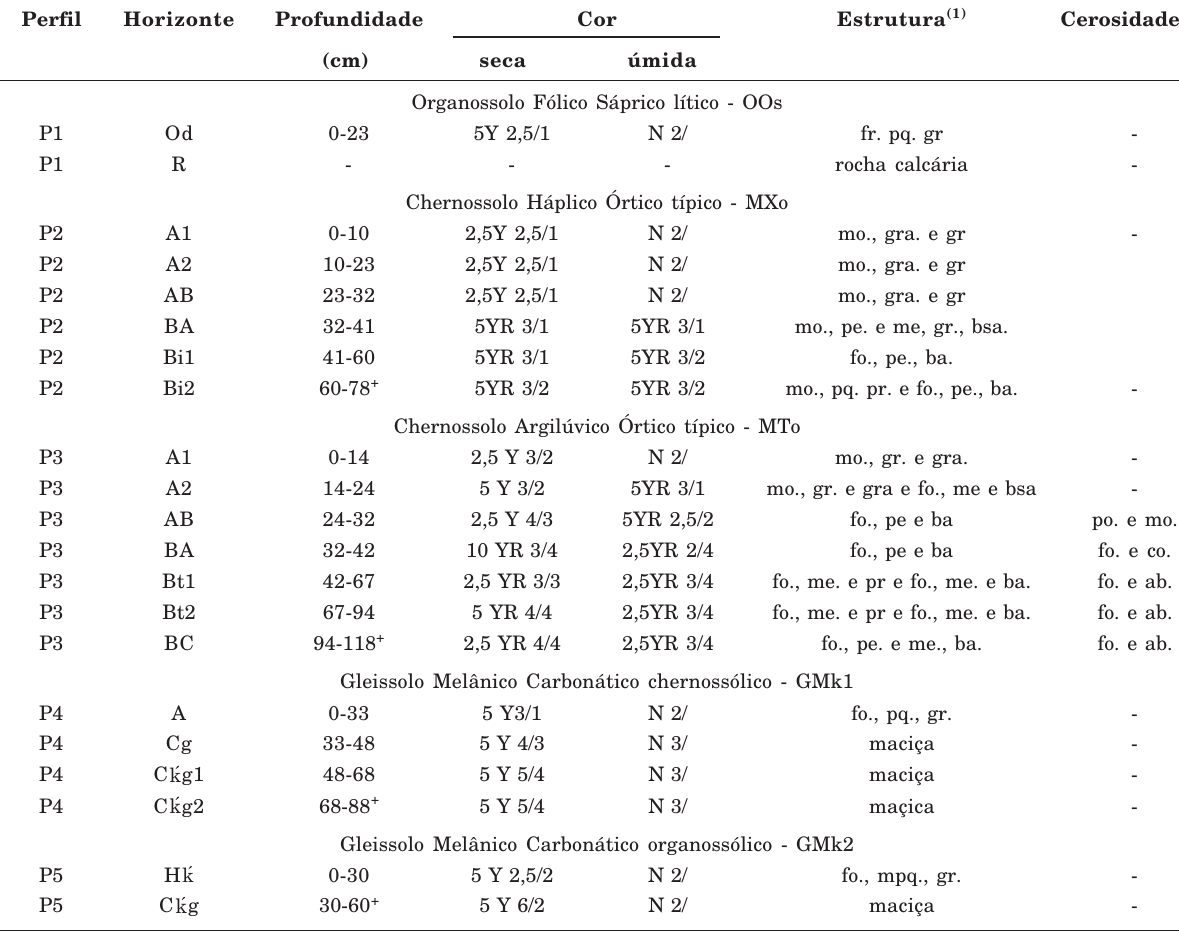
(1) fr = fraca; (1) mo = moderada; (1) fo = forte; (1) mpq = muito pequena; (1) pq = pequena; (1) me = média; (1) gr = grande (1) ba = blocos angulares; (1) bsa = blocos subangulares; (1) gr = granular; (2) po = pouco; (2) co = comum; e (2) ab =